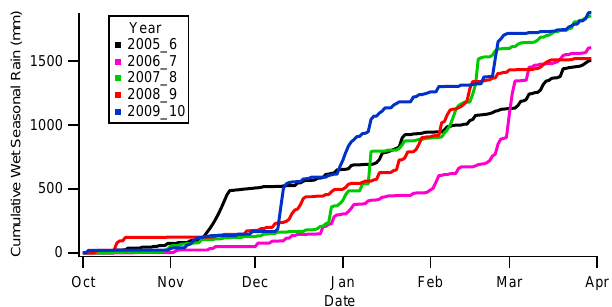
Figure 14. Cumulative rainfall through each monsoon season (Oc- tober through to the following March) from June 2005 to October 2009 as measured at the ARM site.